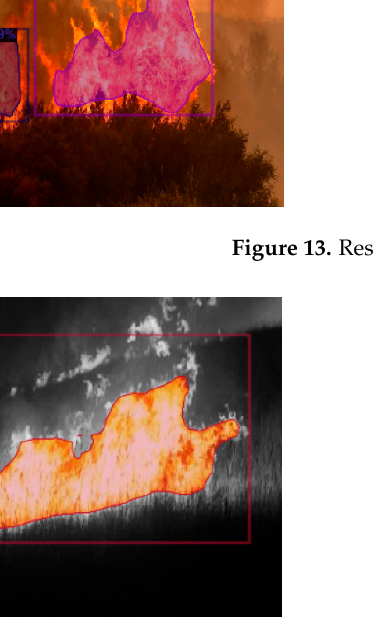
Figure 14. Results of forest fire detection for night images.